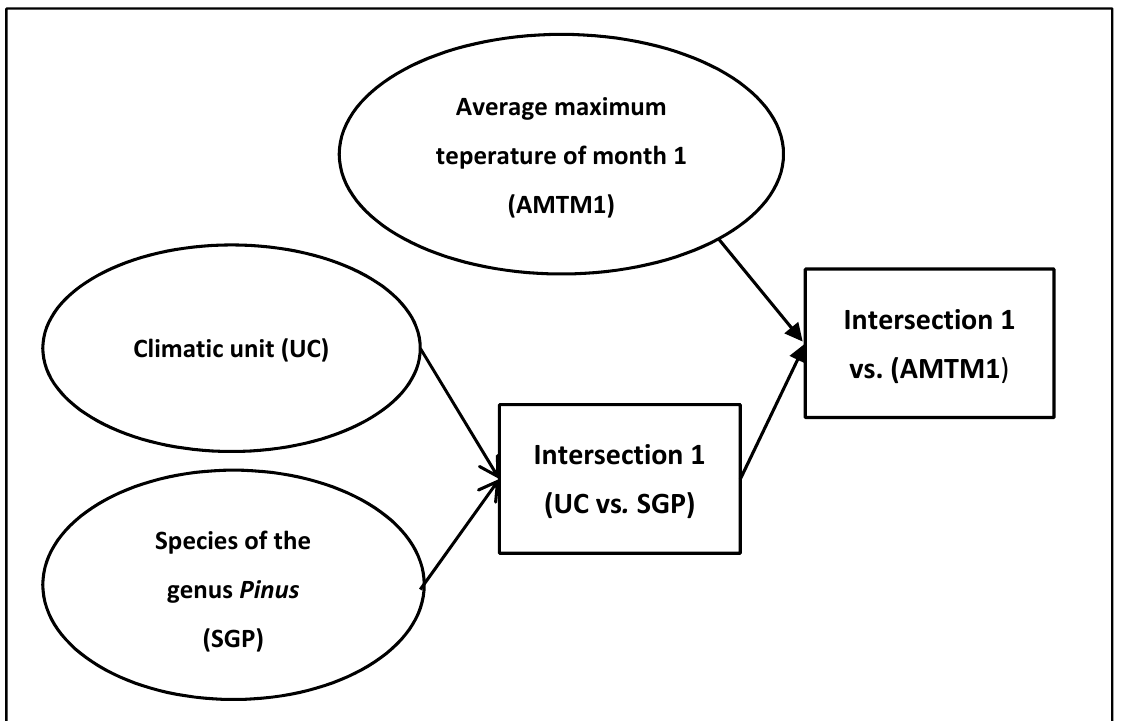
Figure 1. Process for the identification of collection zones.